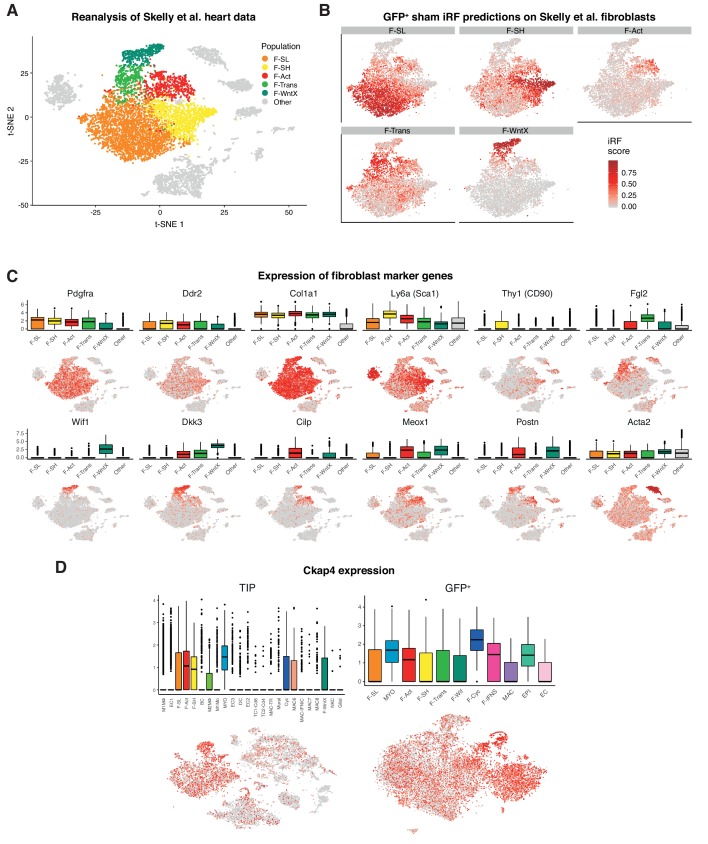
Comparisons with Skelly et al. (2018) and Gladka et al. (2018) scRNA-seq data-sets.(A–C) Reanalysis of Skelly et al. scRNA-seq data. (A) t-SNE plot showing main fibroblast populations detected from clustering analysis and identities according to those described in GFP+. (B) iRF predictions of GFP+ sham populations on fibroblasts from Skelly et al. data-set. (C) Expression of representative marker genes according to box plots and as visualized on t-SNE plots. Shows fibroblast markers (Pdgfra, Ddr2, Col1a1) and sub-population-specific markers. (D) Expression of Ckap4 gene, which was identified by Gladka et al. as a novel marker of activated fibroblasts, as visualized in box and t-SNE plots across TIP and GFP+ sub populations.